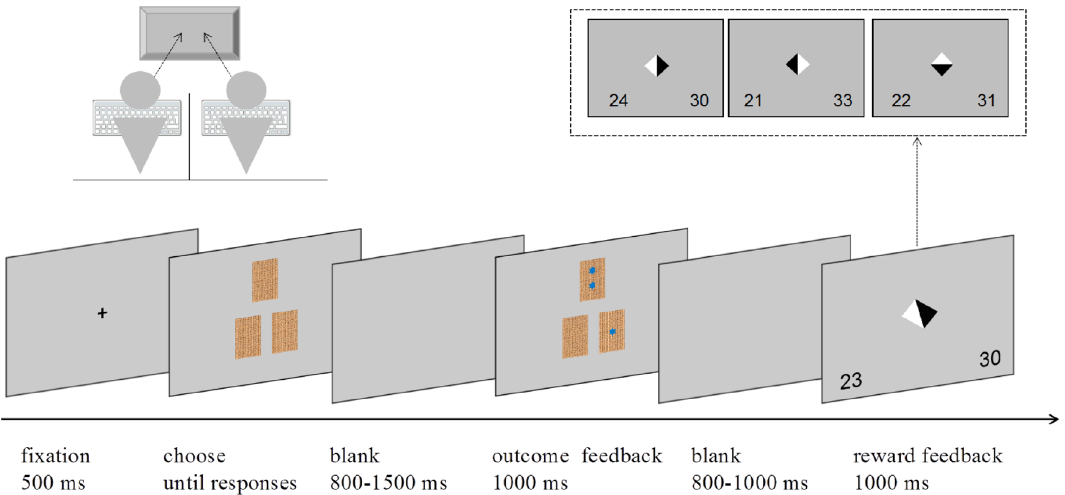
Figure 1. Experimental procedure. Two participants of the same sex compete in a reward task. The participants simultaneously chose one of three cards, concealing zero, one, or two stars. The person who selected the card with more stars gained a